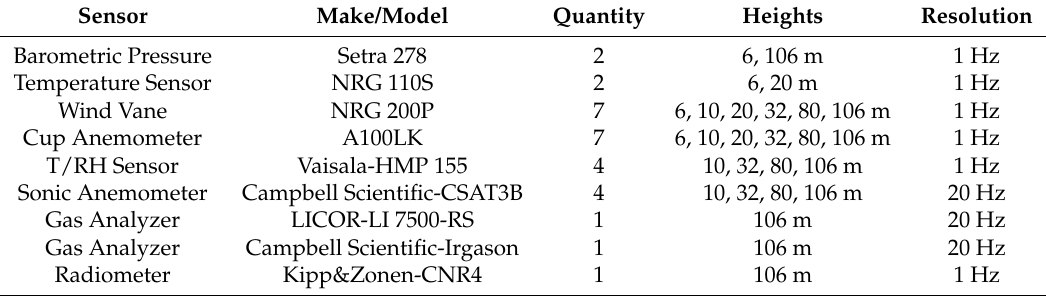
Table 1. List of the sensors installed on the met